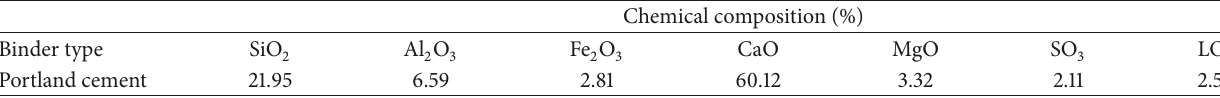
Table 1: Chemical composition of Portland